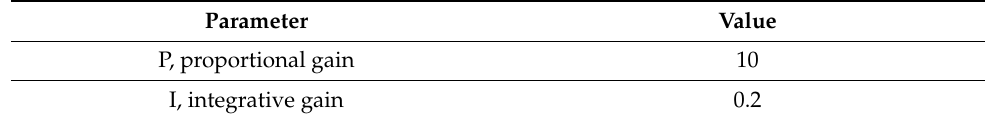
Table 3. Gains used for feedback controller design.